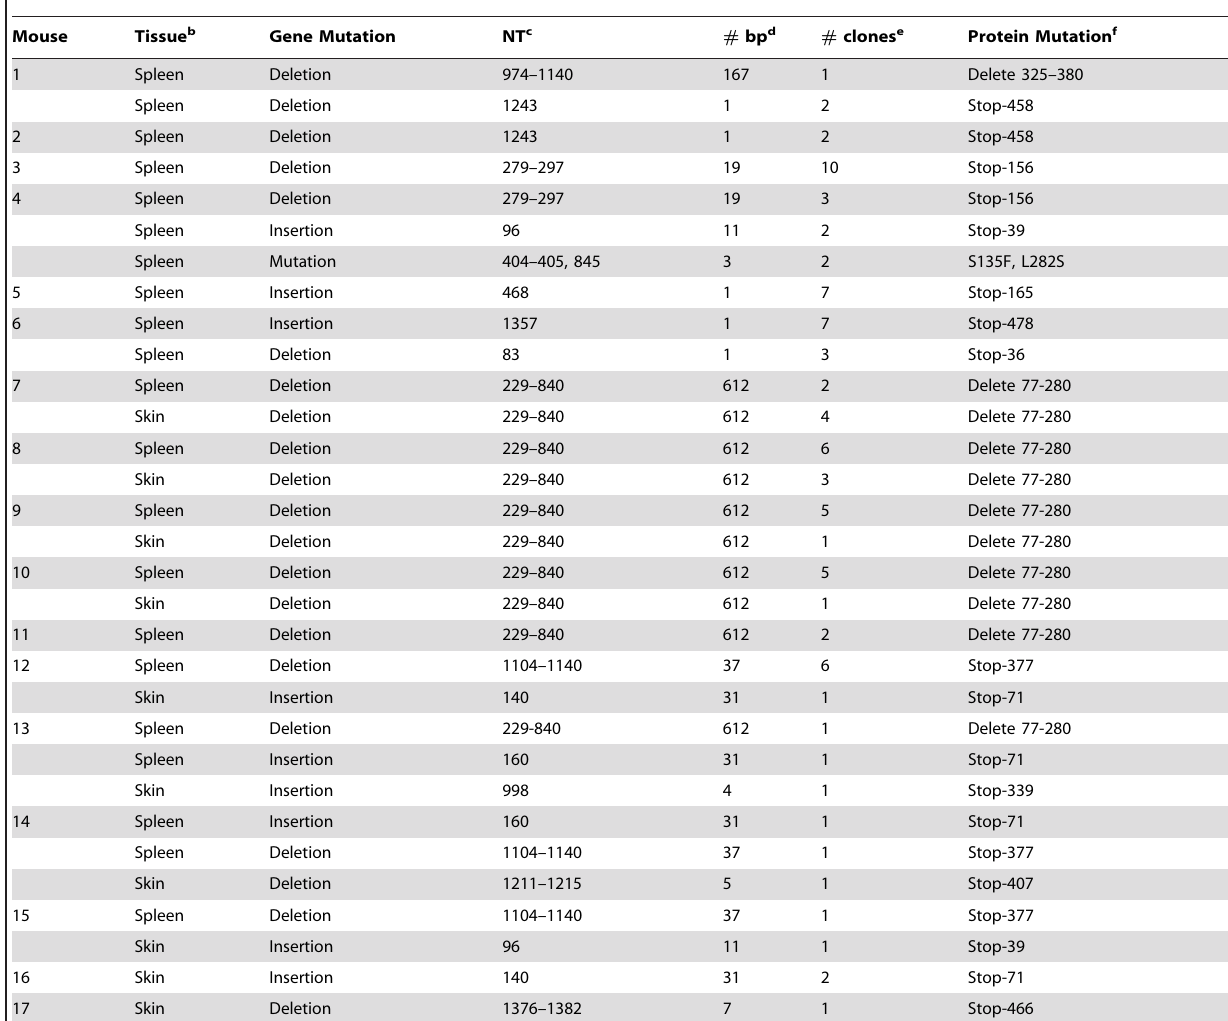
Table 2. Mutations found in covS gene of GAS strain 5448/ covS + during infection in mice. a